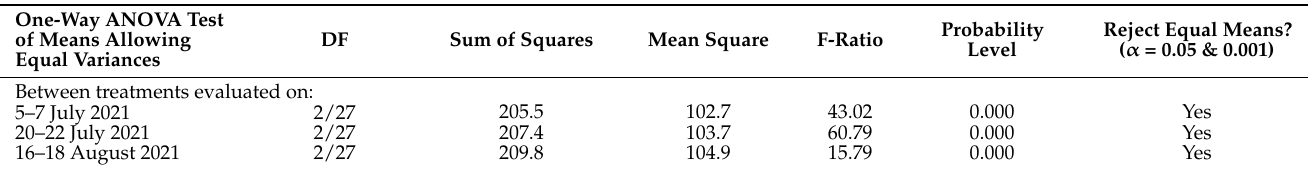
Table 4. The one-way ANOVA test of means allowing for equal variances of the different treatments grouped on the evaluation time interval.